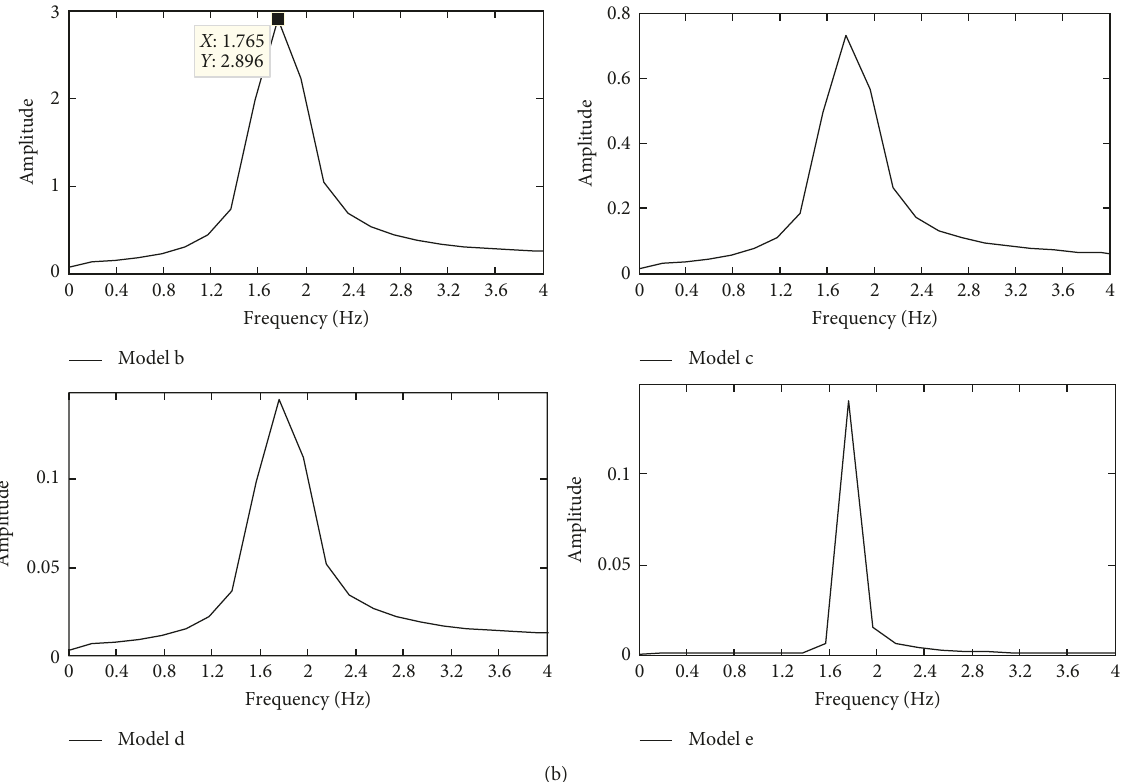
Figure 25: The time and frequency domain when human as loads and mass-stiffness-damping system. (a) The time history of acceleration and frequency domain when human as loads and (b) the frequency domain when human as mass-damping-stiffness